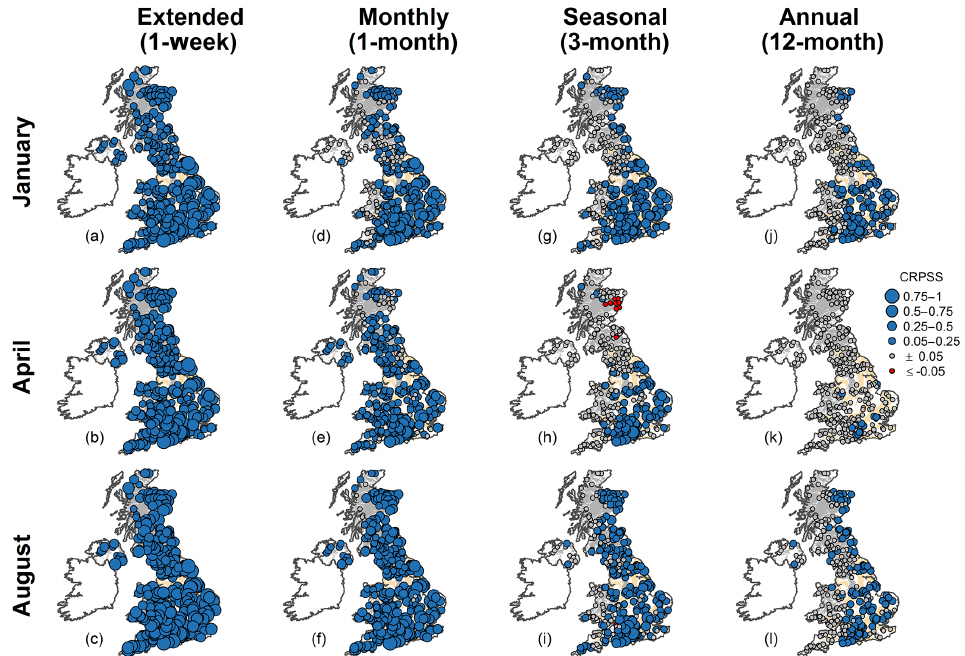
Figure 7. ESP skill for individual forecasts made at each of the 314 catchment locations for four sample lead times (columns) and three initialization months (rows). Larger and smaller circles represent higher and lower skill from CRPSS, respectively, with blue circles when ESP is more skilful than benchmark climatology and red when ESP is less skilful. Grey circles represent neutrally skilful forecasts (i.e. CRPSS values between ±